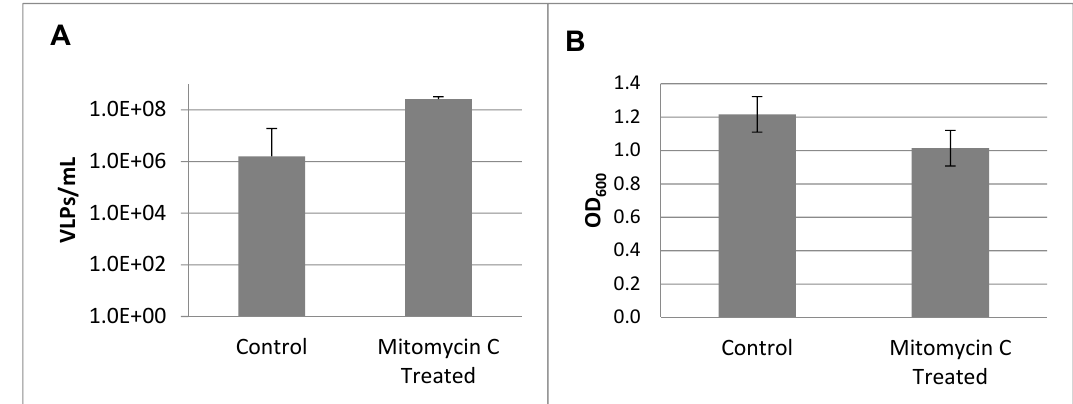
Figure 1. ( A ) Viral-like particles (VLPs) enumerated via epifluorescence microscopy after mitomycin C induction of Shewanella fidelis 3313. ( B ) Bacterial turbidity measured at OD 600 . All measurements were recorded at 24 h after treatment.